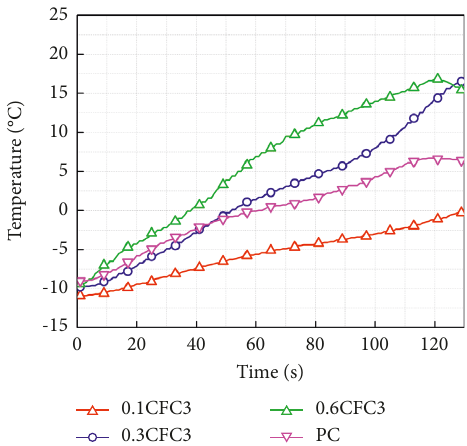
Figure 10: Comparison of temperature rise curves at different